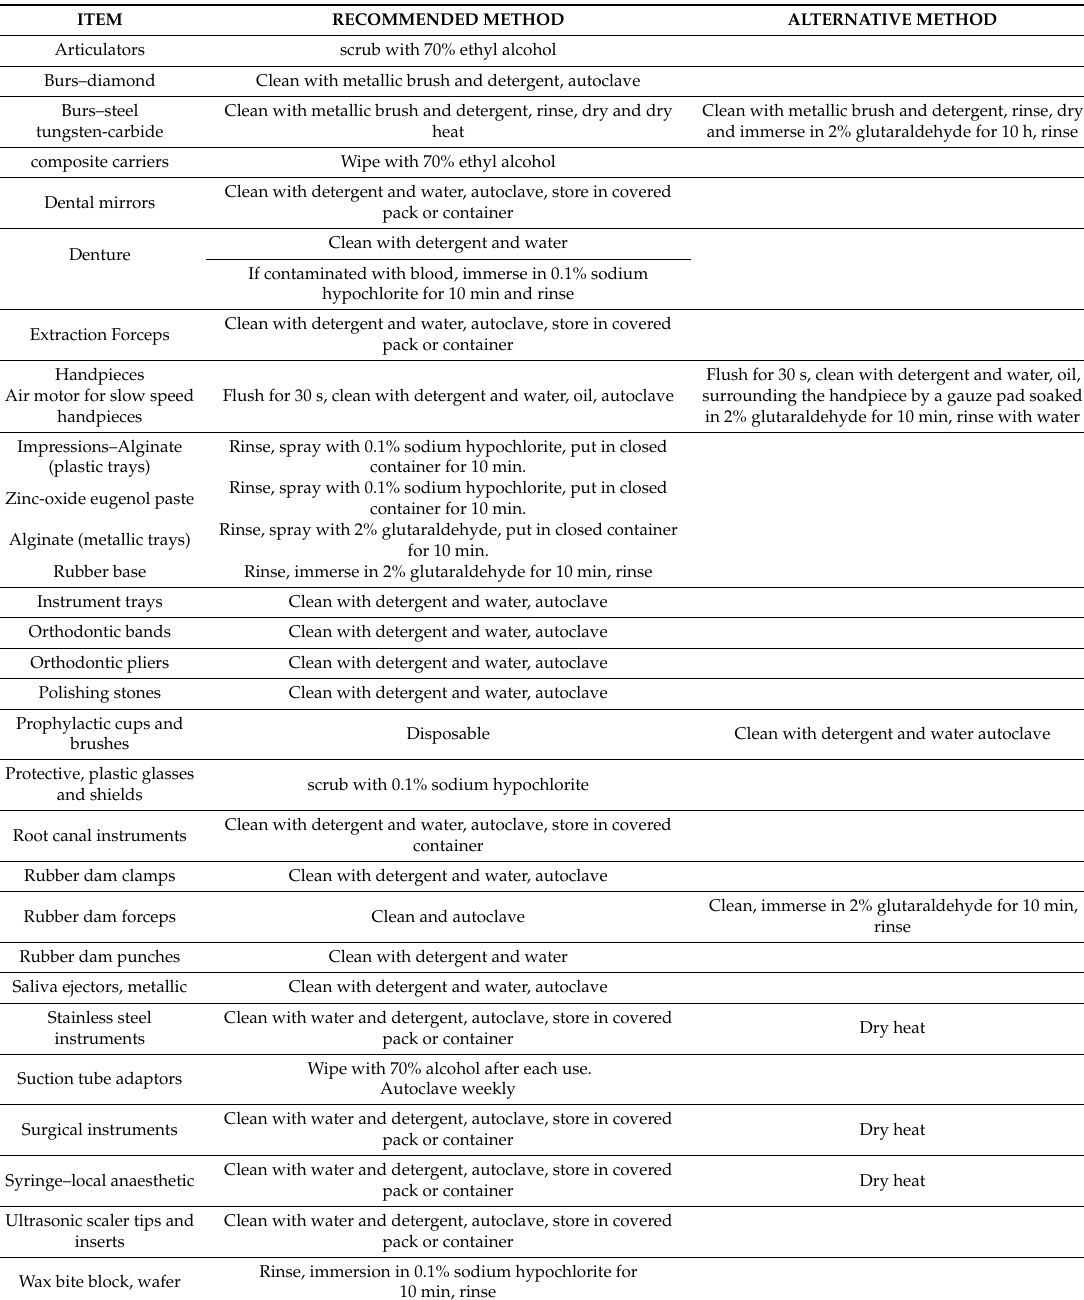
Table 5. instrument disinfection procedures.